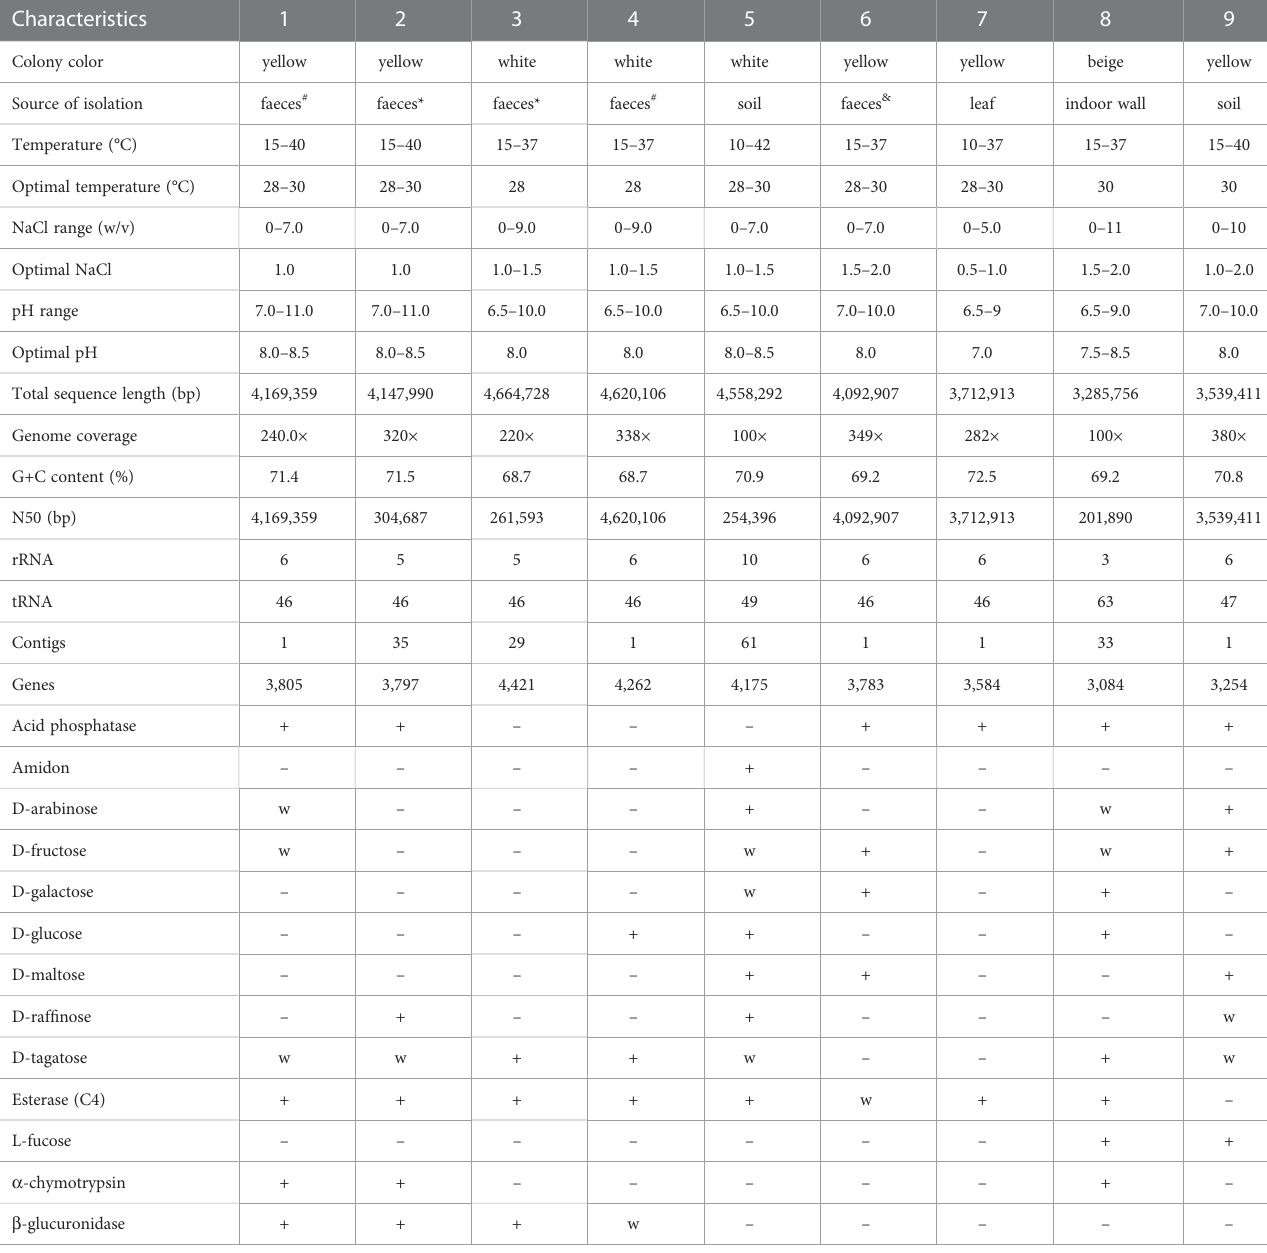
TABLE 1 Differential characteristics between our four isolates and the type strains of closely related species.